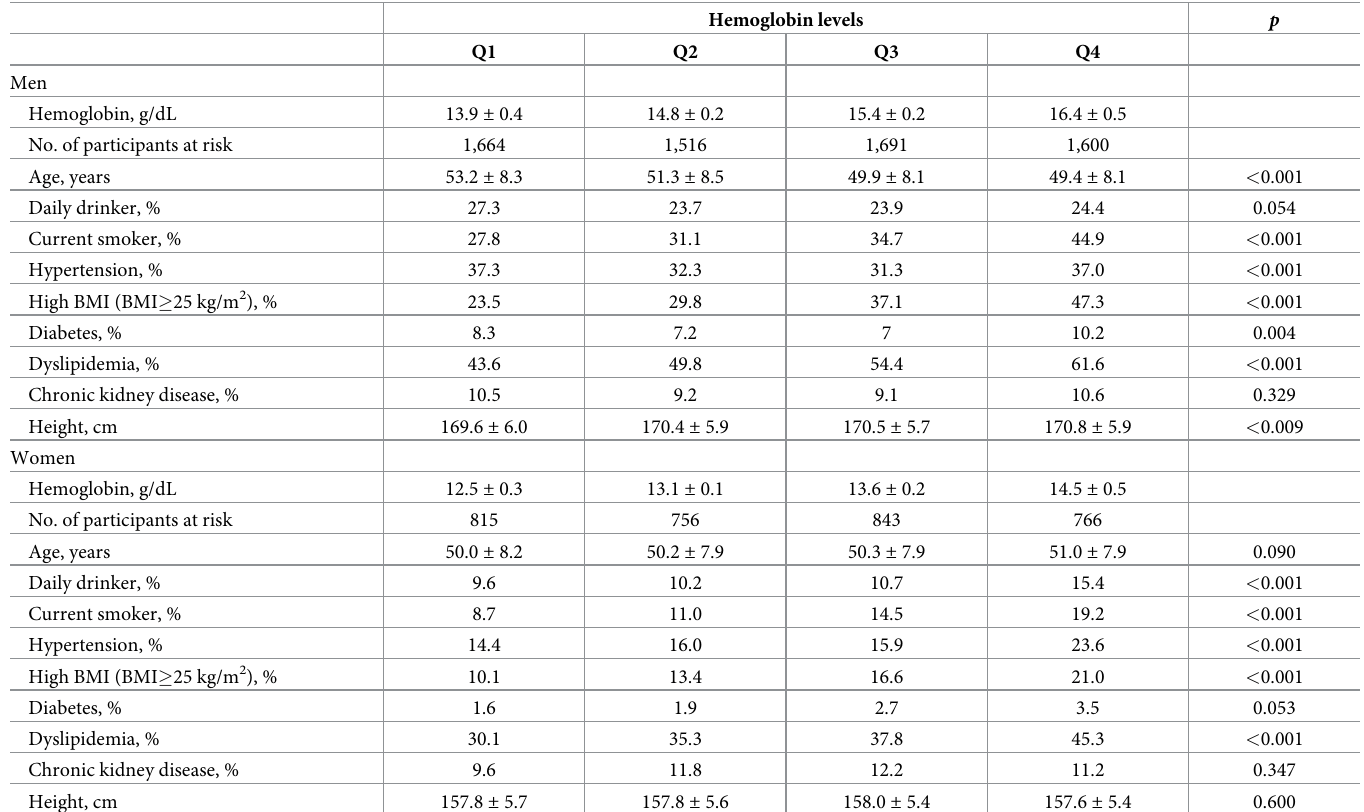
Table 1. Characteristics of the study population.